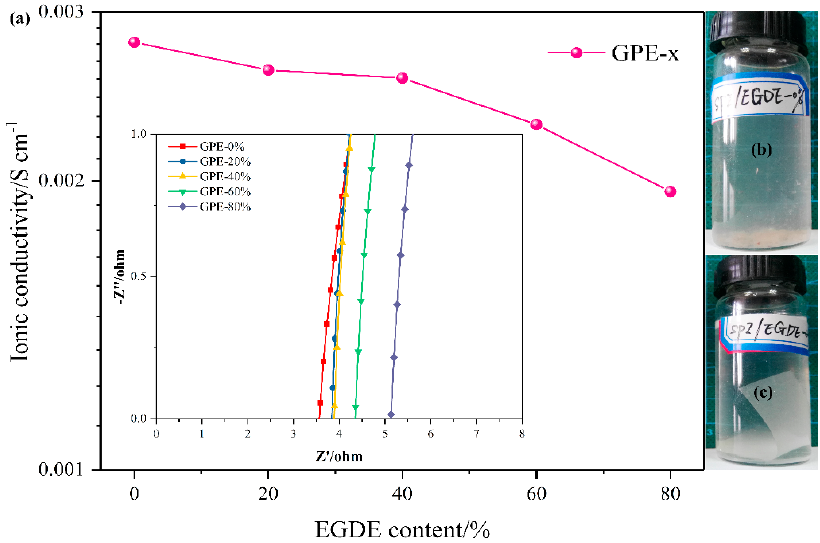
Figure 4. Ionic conductivities of GPE- x prepared by SPI/EGDE- x membranes ( a ) and water resistance of SPI/EGDE- x membranes ( b , c